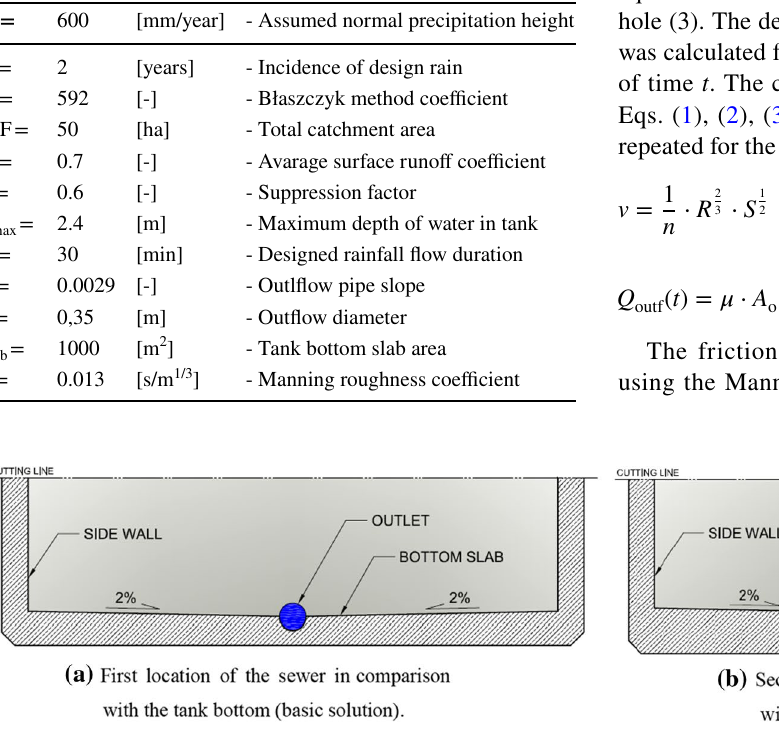
Fig. 1 a First location of the sewer in comparison with the tank bottom (basic solution). b Second location of the sewer in comparison with the tank bottom (alternative